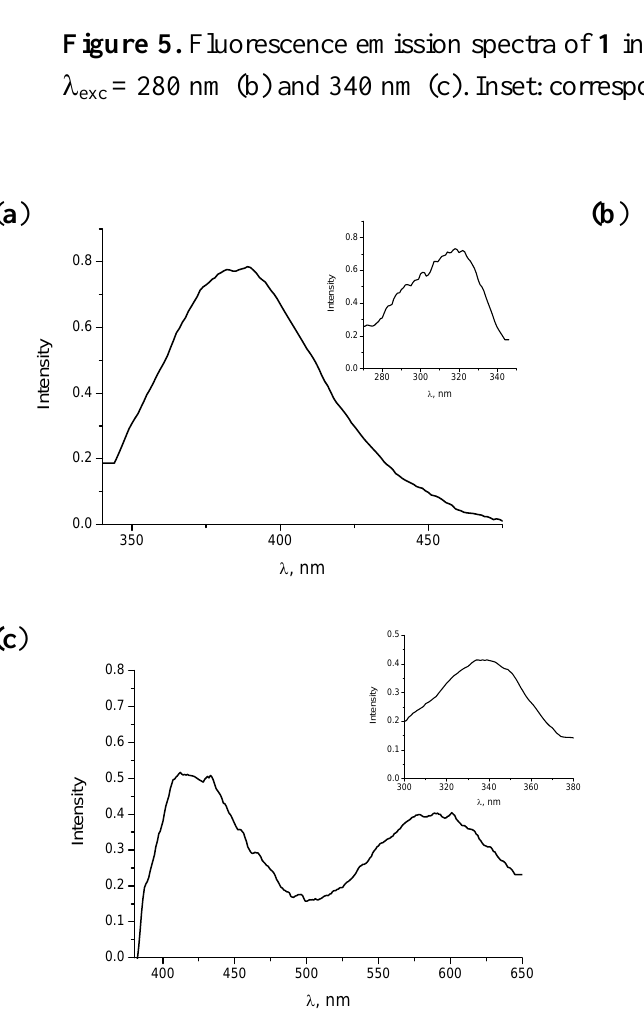
= 300 nm (a) and in DMSO exc